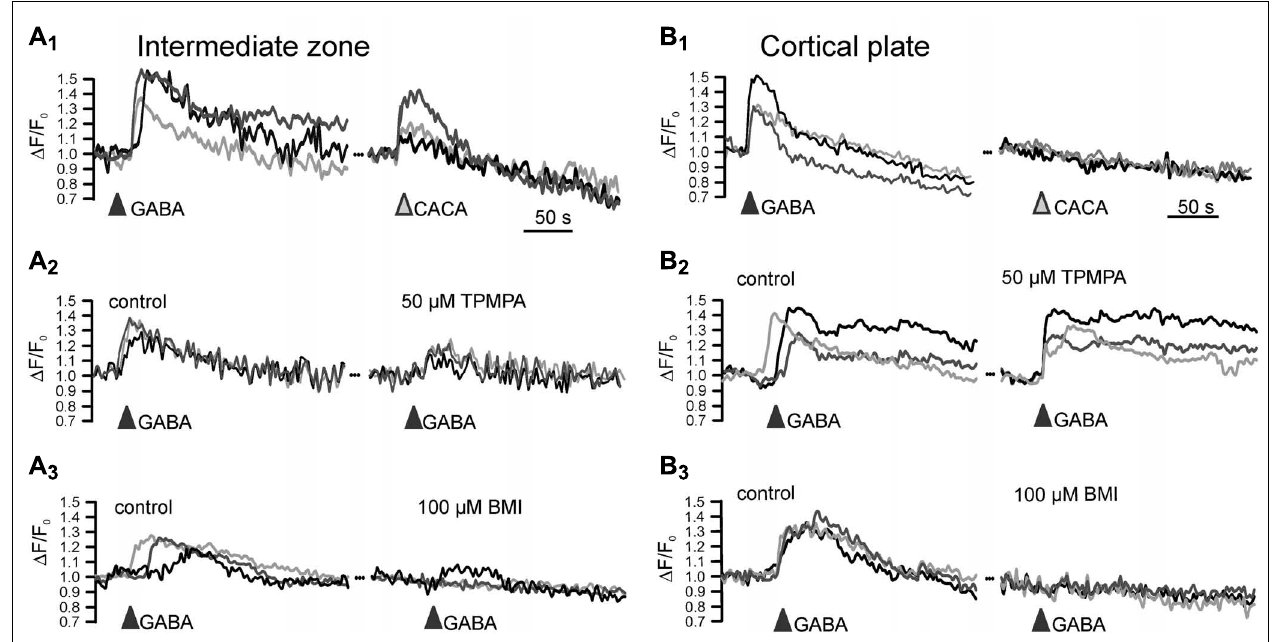
FIGURE 2 | Functional expression of ρ subunit containing GABA A receptors in the intermediate zone. Microfluorimetric registration of Ca 2 + transients induced by application of 100 μ M GABA and 100 μ M of the ρ subunit specific agonist cis-4-amino-crotonic acid (CACA) in neurons from the intermediate zone (A) and cortical plate (B) . Note that CACA induced Ca 2 +